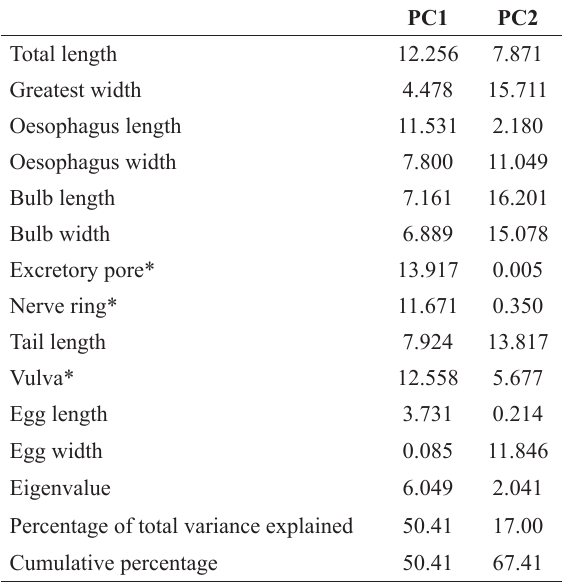
Results of a principal component analysis of morphometric variables of males of A.